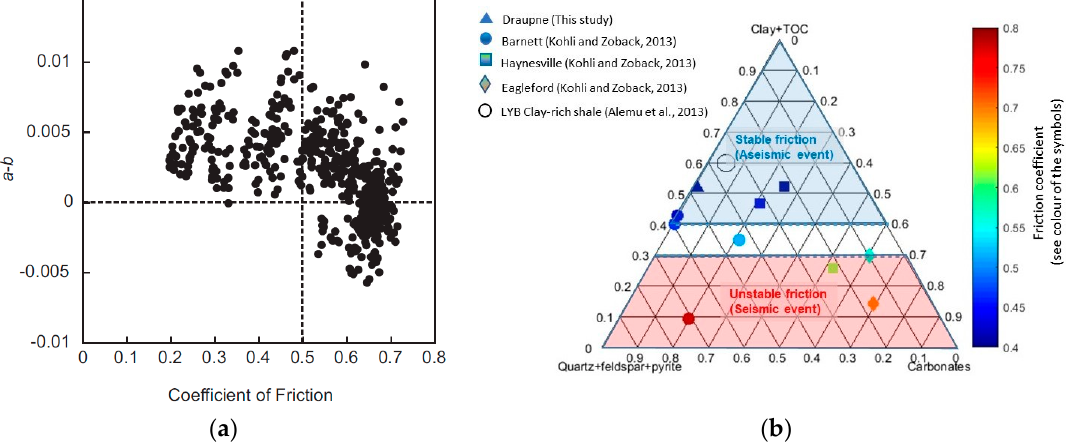
Figure 14. ( a ) correlation between the friction rate parameter ( a-b ) and the coefficient of friction (after [48]). The data in the plot ( a ) represent a wide range of materials. ( b ) Ternary plot of mineralogy and its relation to seismic potential of rocks (modified after [20]) with the Draupne and Rurikfjellet shales included. The colour bar shows the friction coefficient.